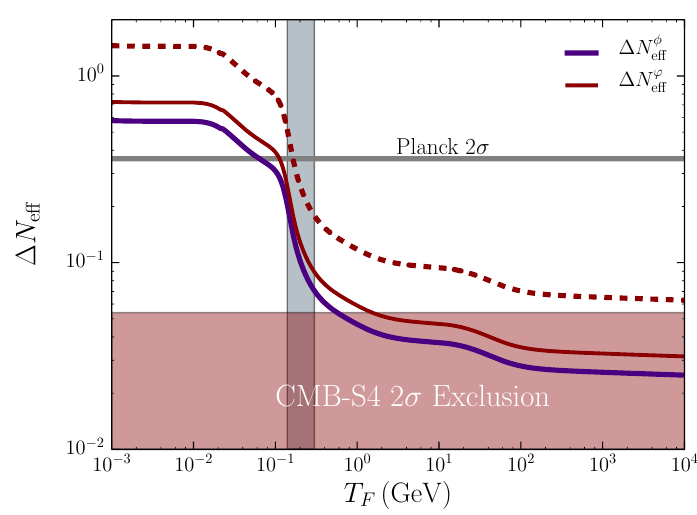
Figure 4 . The contributions to N e(cid:11) from (cid:30) and ’ as a function of the temperature where (cid:30) decouples from the Standard Model, T F , assuming g ’ = g (cid:30) = 1. The grey region indicated the temperature of the QCD phase transition. The indigo line shows the contribution of (cid:30) to N e(cid:11) when m (cid:30) < 1 eV and is stable. The red line shows the contribution from ’ to N e(cid:11) when it comes into equilibrium with (cid:30) . The solid (dashed) curve assumes ’ is not (is) in equilibrium at T F . We show the current 2 (cid:27) exclusion from Planck in grey and the projected 2 (cid:27) exclusion from CMB-S4 in red (assuming (cid:27) ( N e(cid:11) ) = 0 : 027). The case of interest for large g N has T F 300 MeV and would (cid:25) be detectable with CMB-S4 in all cases. We used the lattice measurement of s=T 3 from [37]